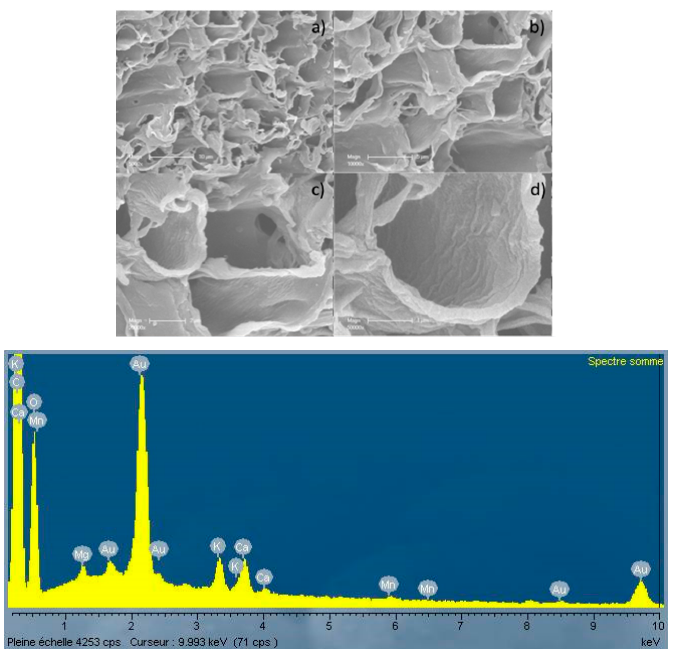
Figure 3. SEM photographs and X-ray fluorescence analysis of the surface of the biochar produced after pyrolysis of wood particles at 500 °C and different enlargements ( a ) ×5000; ( b ) ×10,000; ( c ) ×20,000; and ( d ) ×50,000.